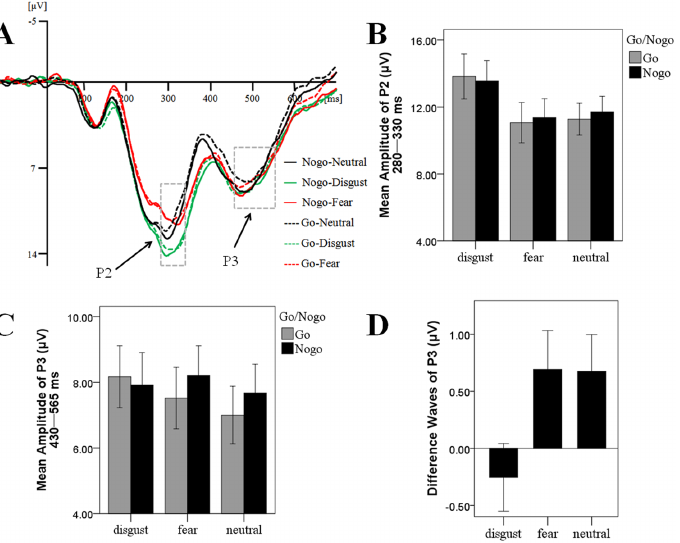
Fig 2. The ERP Results for Strongly Masked Condition. (A) The averaged ERP under different emotional contexts; (B) P2 amplitude under different emotional contexts; (C) P3 amplitude under different emotional contexts; (D) The difference waves (no-go condition minus go condition) of P3 amplitude under different emotional